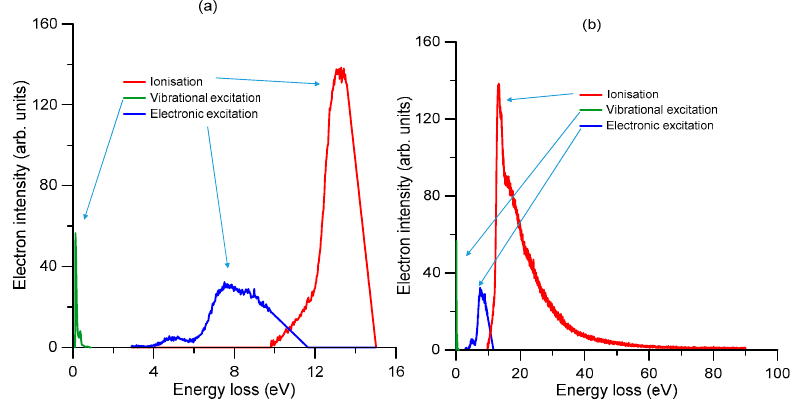
Figure 8. Angle-averaged energy loss distribution functions for ( a ) 15 eV and ( b ) 90 eV incident electron energies, as used in the present simulations. See also the legend in the figure to define the various open scattering processes.